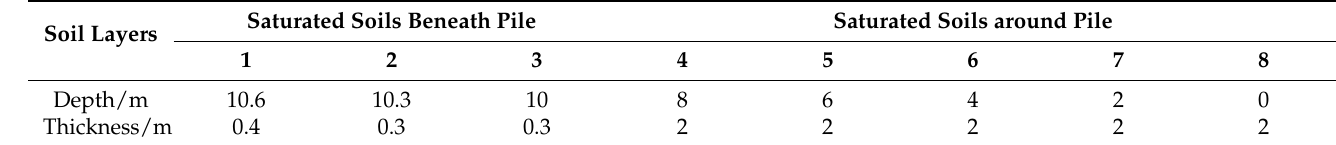
Table 1. Parameters of the soil layers.